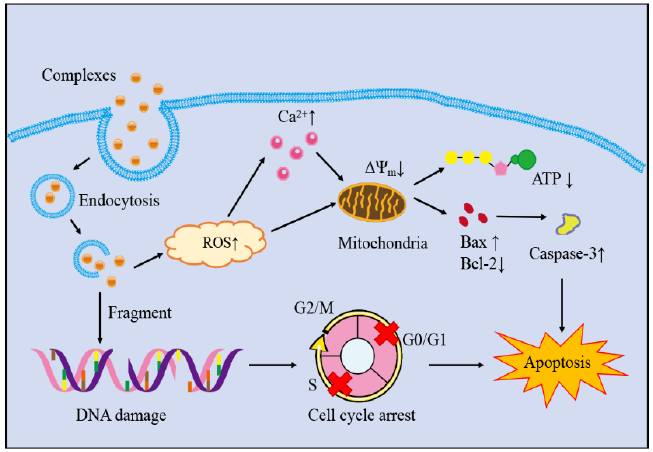
Figure 12. The apoptotic mechanism of the complexes inducing SGC-7901 cells.